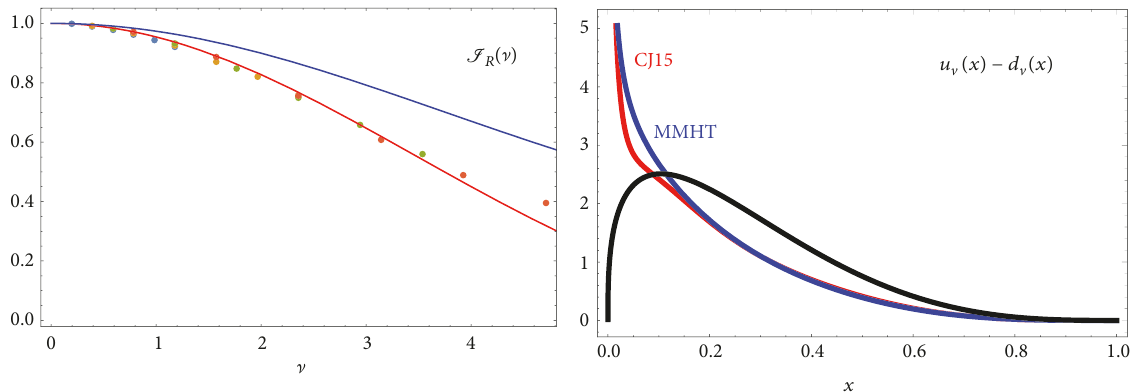
Figure 36: Left: real part of light-cone ITD (real part), matched from pseudo-ITD via Equation (93). The matched ITD was fitted to a model ITD. For comparison, the ITD corresponding to the CJ15 phenomenological set is also shown. Right: final PDF resulting from the data in the left plot, together with two phenomenological PDFs: CJ15 [214] and MMHT [212]. Source: arXiv version of [81], reprinted with